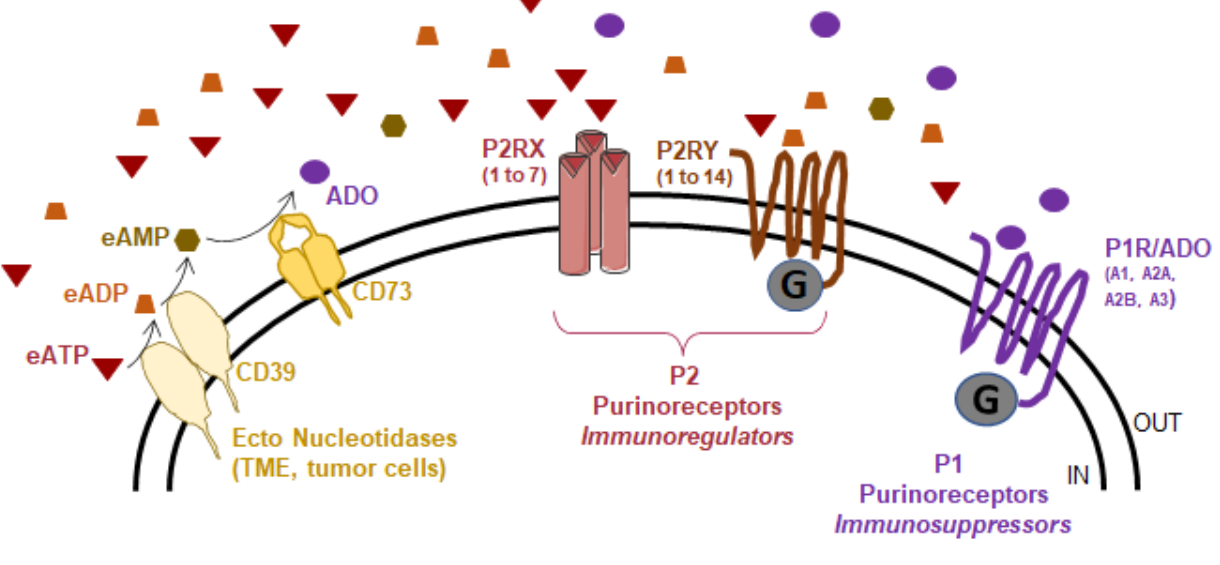
Figure 2. The purinergic landscape.